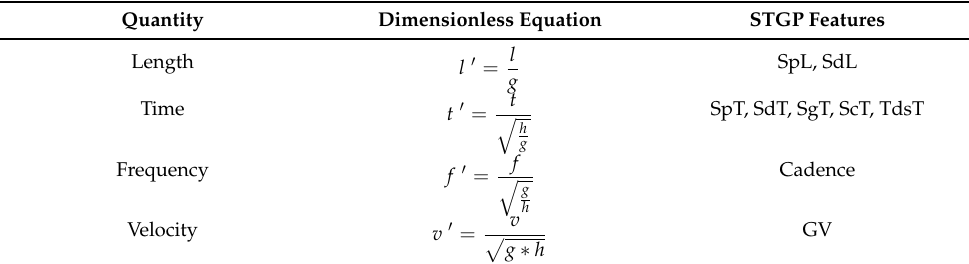
Table 5. Dimensionless forms related to spatial-temporal gait features.